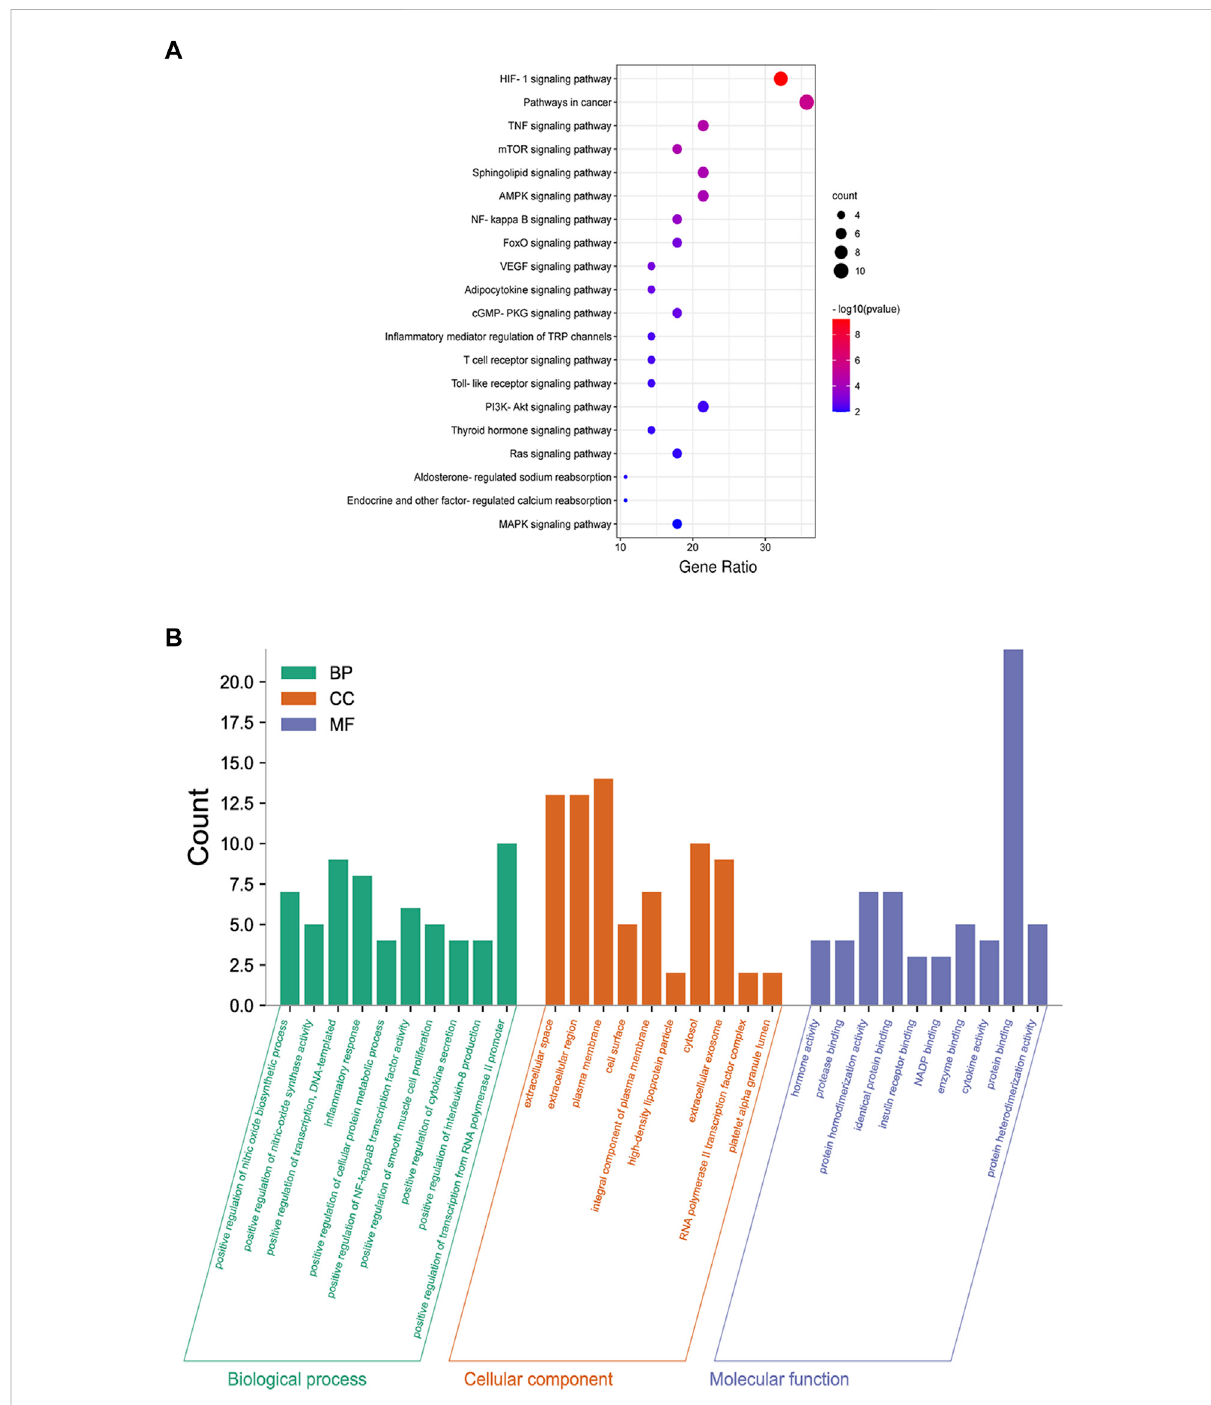
FIGURE 7 Functional enrichment analysis of common targets. (A) Dot bubble plot of the top 20 KEGG pathways enriched by the common targets of DKD and DSS. Size of the dots represents the number of enriched genes, and the color represents − log 10 ( p value). (B) Histogram plot of the